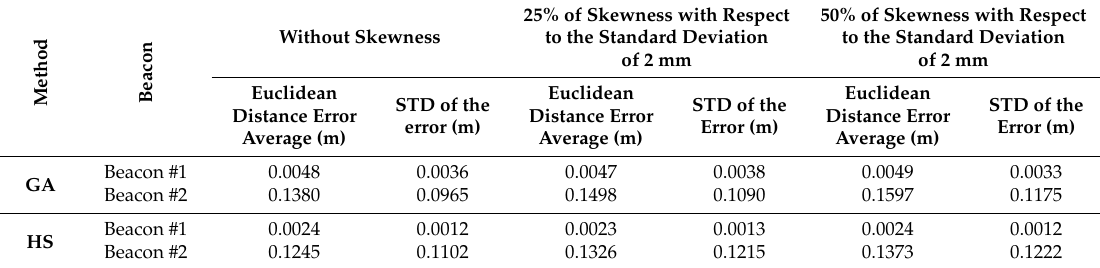
Table 6. Results adding a skewness factor in the distance measuring